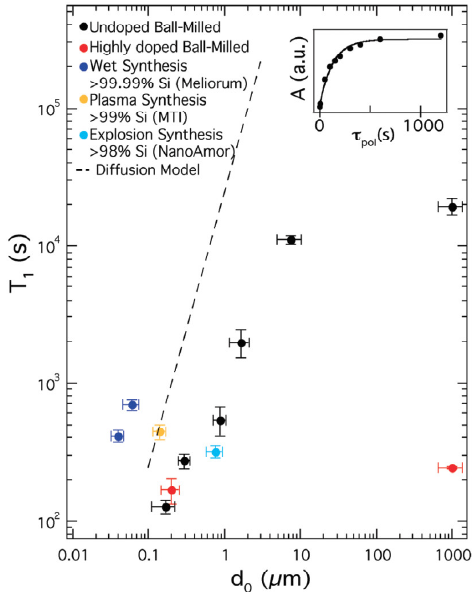
Figure 17. NMR Properties of Si particles. Nuclear spin relaxation ( T 1 ) times at 2.9 T as a function of particle diameter d 0 for various Si particles. Vertical error bars are from exponential fits to relaxation data; horizontal error bars represent the dispersion of size distributions. Inset: Fourier-transform NMR peak amplitude, A, as a function of polarization time for the ball-milled high-resistivity particles with d 0 = 0.17 µ m. T 1 values were measured using a saturation recovery spin echo pulse sequence. (Reprinted with permission from Reference [11]. © (2009) American Chemical Society).